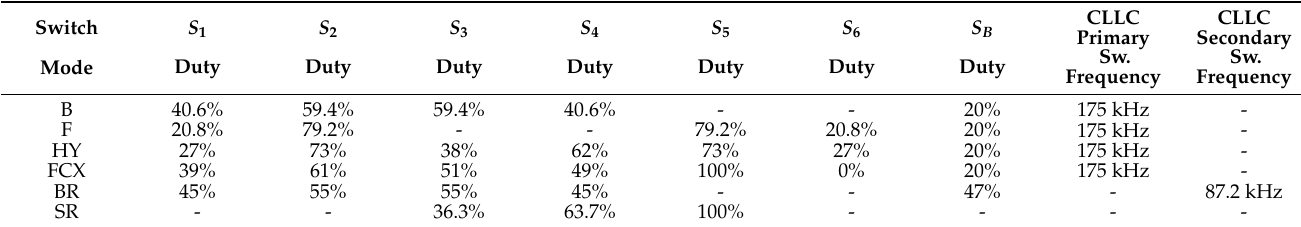
Table 9. Calculated duty cycle and switching frequency chart for fuel cell voltage at 180 V and battery at 330